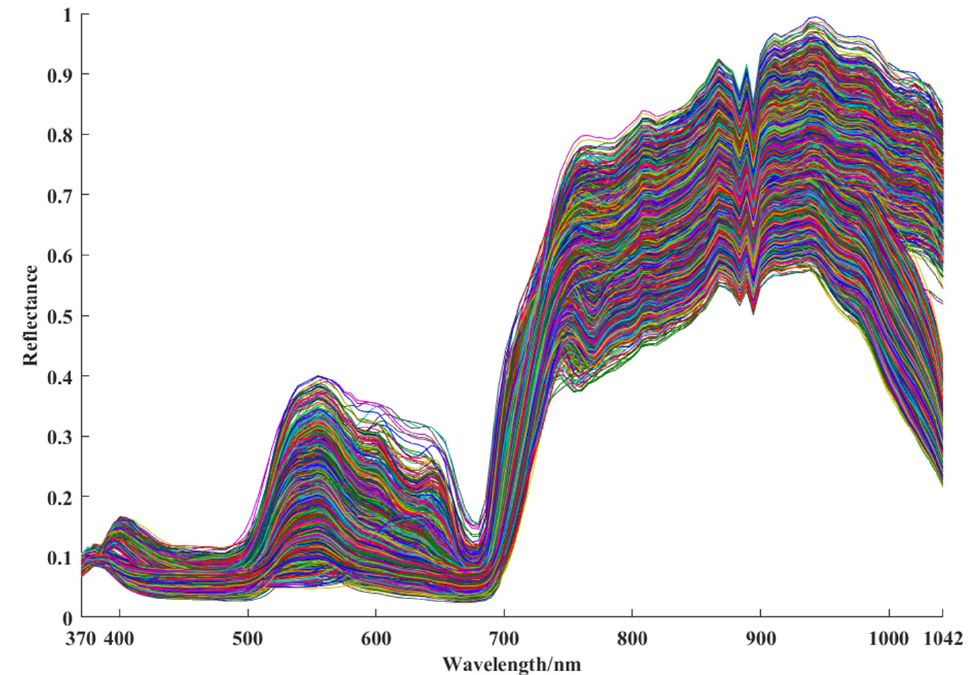
Figure 3. Original reflectance spectra of all leaf samples.